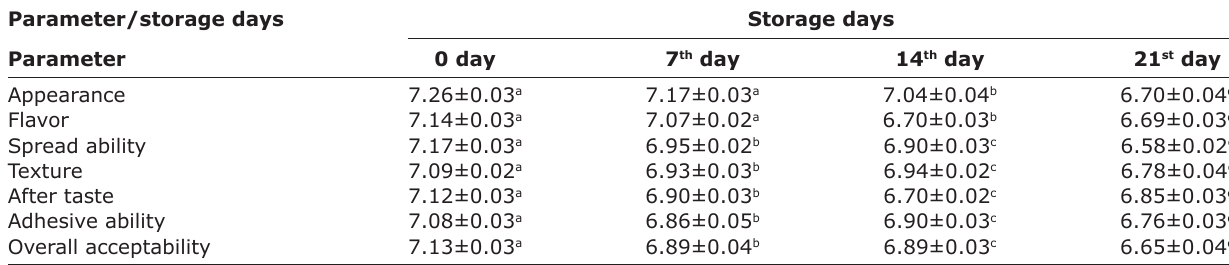
Table-4: Sensory evaluation of meat spread at refrigeration temperature